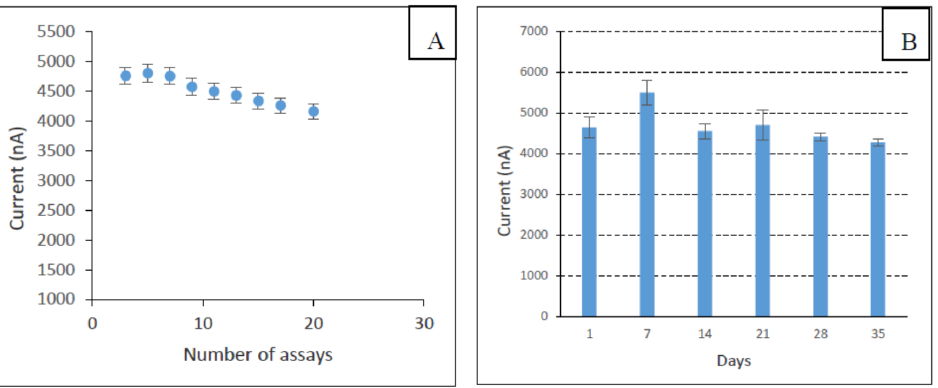
Figure 11. The repeatability of the developed biosensor ( A ) and storage stability of the fabricated biosensor ( B ).